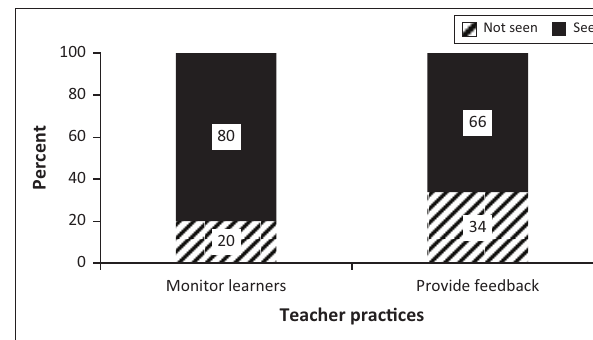
FIGURE 5: Teachers’ oral feedback practices.